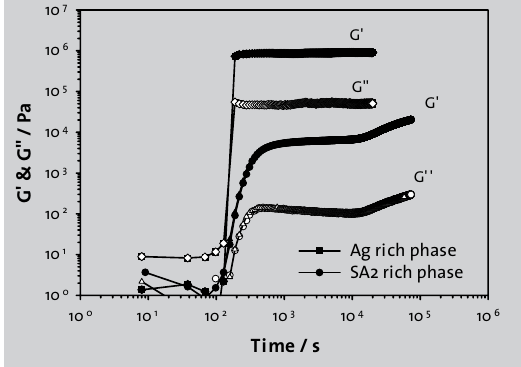
Figure 2 (left): Comparison of the gelation of maltodextrin and agarose rich phases (denot- ed respectively SA2 rich phase and Ag rich phase) obtained from the phase separation of 12.5 % SA2 / 5 % Ag mixture (amplitude strain: 0.5%, amplitude fre- quency: 1 rad/s, T : 10ºC). cup Figure 3: Typical large deformation behaviour of maltodextrin rich phase gel, together with proof of reproducibility of the measurements, obtained from the phase separation of 12.5 % SA2 / 5 % Ag mixture using an ARES rheometer equipped with a vane geometry (shear rate: 0.05 s -1 , T : cup